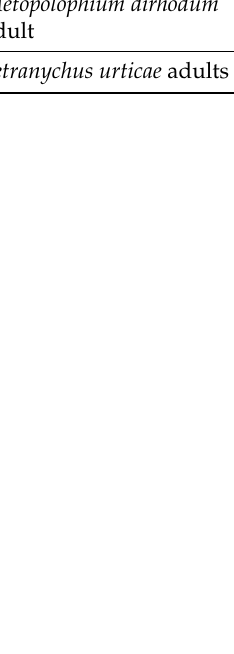
Table 3. Main Mentha aquatica essential oil